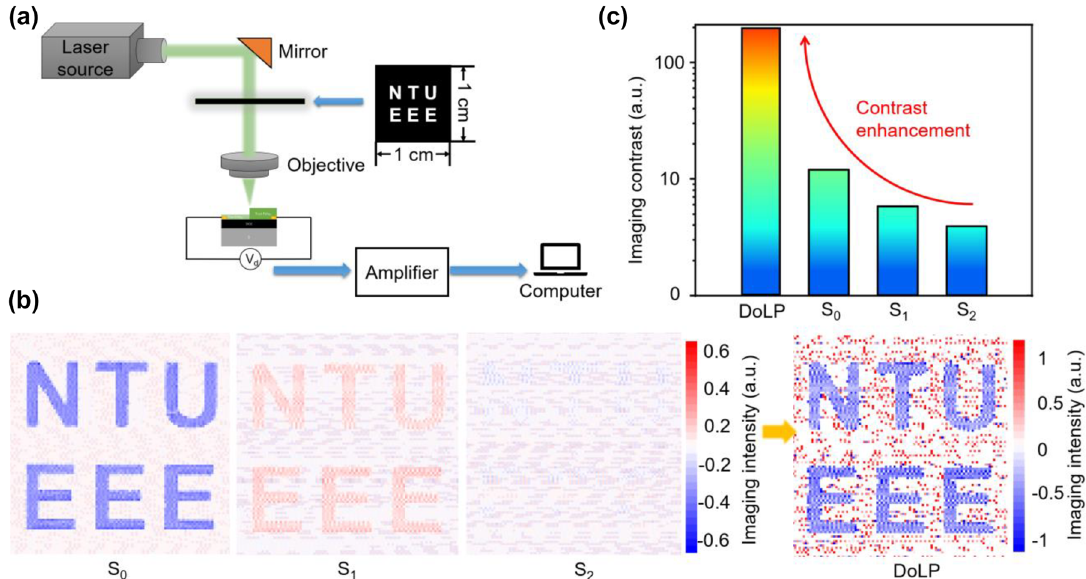
Figure 5: Polarization imaging measurements using the PdSe test system. (b) The calculated normalized contrast constant of S contract constant with the 8-neighbors contrast calculation method, indicating the extraordinary polarization detection ability of this